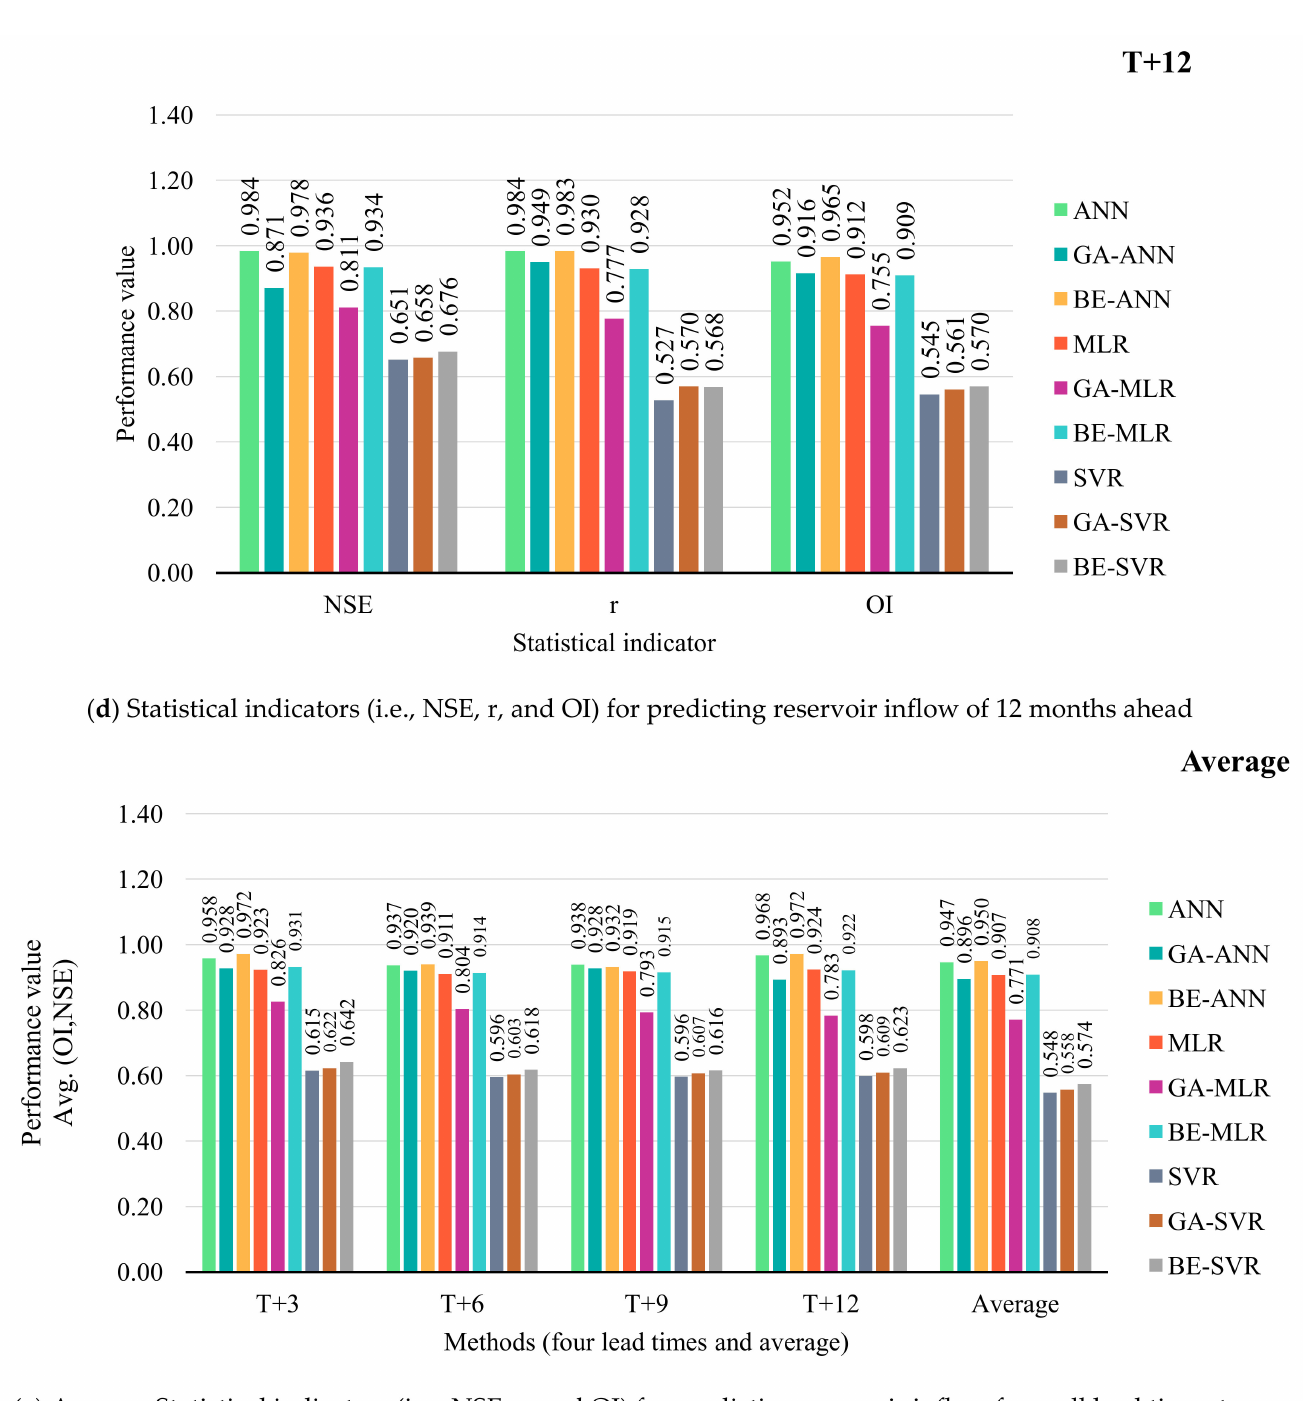
Figure 4. Comparison of nine ML models’ prediction accuracy (i.e., OI, NSE, and r) for four lead